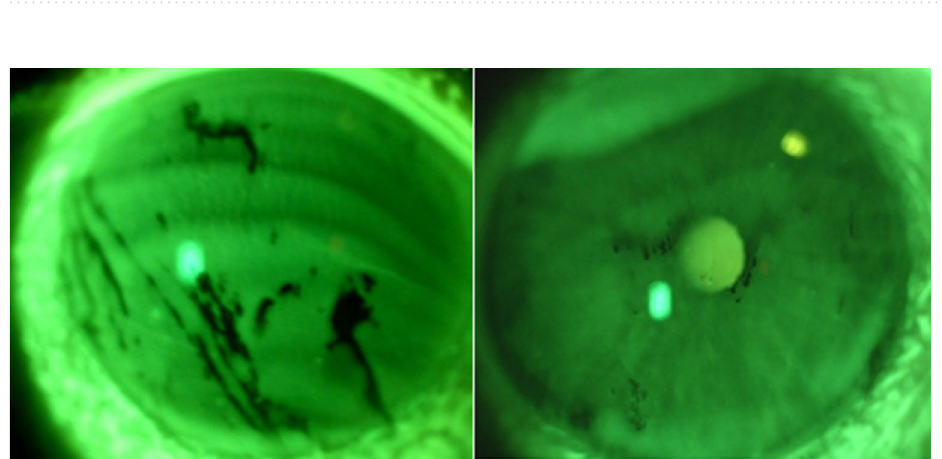
Figure 2. TBUT test using a slit lamp by a wide open slit in blue light (unpublished picture taken by Witold